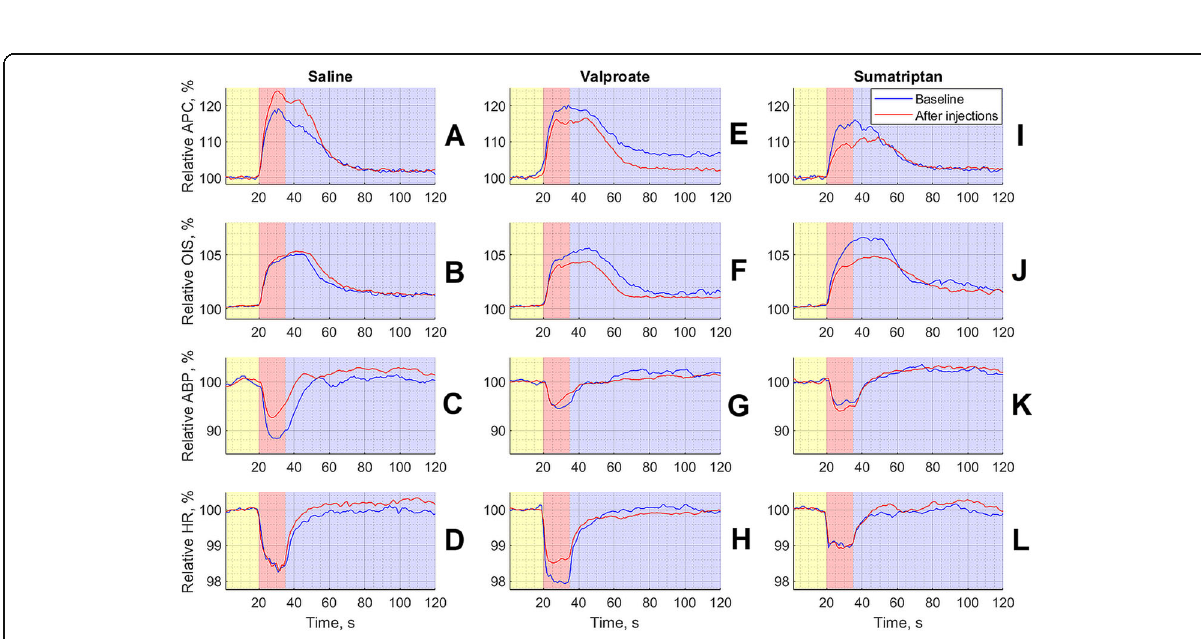
Fig. 5 Summarized responses of both PPG and hemodynamic parameters to CCW electrical stimulation averaged over studied animals separately in each of three groups. Panels a – d show responses for the group that received infusion of saline, panels e – h for the group of valproate, and panels i – l for the group of sumatriptan. In all panels, yellow, red, and violet highlighting indicates pre-, during-, and post-stimulation phase, respectively. The time scale in seconds is shown in X-axis of each graphs, whereas the normalized parameters in a percentage are shown in Y- axes. The blue curve in each graph is the response of the measured parameter during the baseline stage, and the red curve is the response after an infusion of a respective substance. All curves were calculated as mean over three steps of the substance